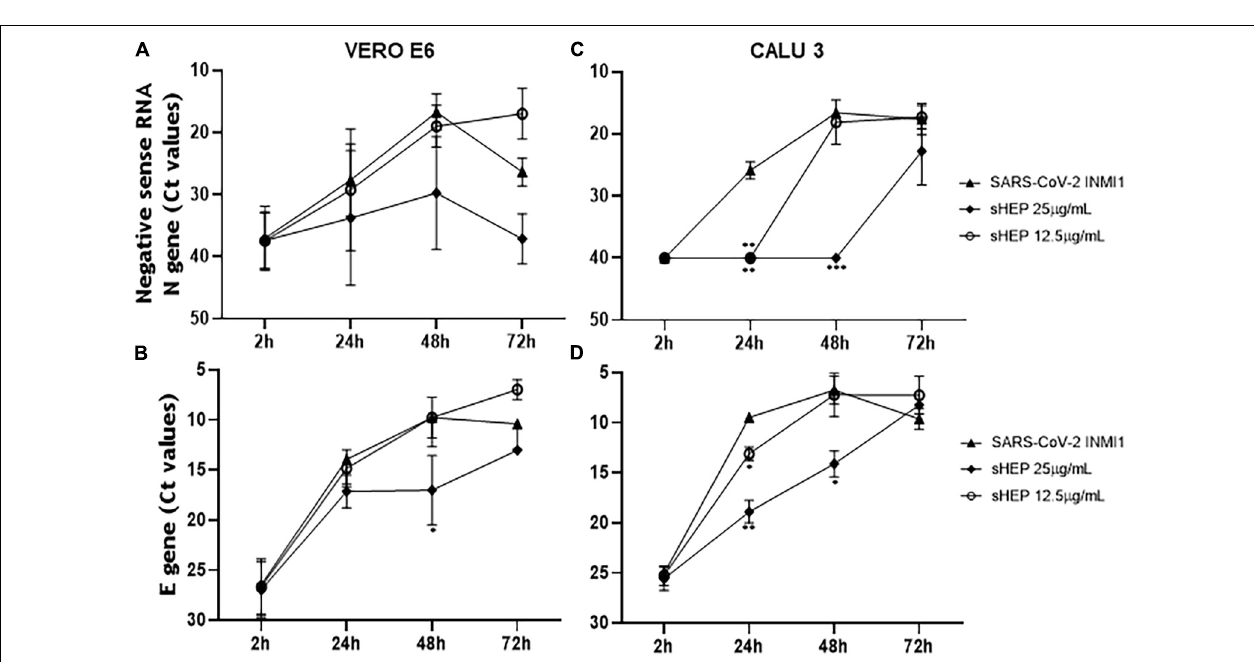
FIGURE 2 | infected VERO E6 cell: arrows point to membrane bound vacuoles containing numerous viral particles. Mature viral particles are visible at the cell surface (arrowheads). Panel (C) among infected VERO E6 cultured in presence of sHEP 25 µ g/mL, numerous uninfected cells were observed showing normal intracellular morphology and no sign of viral presence, as here shown. Panel (D) percentage of infected cells (top graph) and mean number of viral particles counted within vesicles (bottom graph) measured in infected cultures were compared to those observed among cultures infected and treated with 25 µ g/mL sHEP (SARS-CoV-2 + sHEP). The differences were significant. Data reported as means values ± SD (** p < 0.01; *** p < 0.001; no asterisk, p ≥ 0.05). Panel (E) sHEP 25 µ g/mL treated SARS-CoV-2 infected cell. Arrows point to membrane bound vacuoles containing typical viral particles. Mature viral particle is visible at the cell surface (arrowhead). Higher magnification of viral particle is visible in the boxed area: black dots are visible inside the viral particles due to cross section through the nucleocapside. Panel (F) higher magnification of an infected cell showing numerous single virions, or small group of virions, enclosed in single membrane vacuoles (arrows). N, nucleus; m, mitochondrion; rER, rough endoplasmic reticulum. Scale bars: A,B = l µ m; C = 2 µ m; E = 500 nm; F = 200 nm.